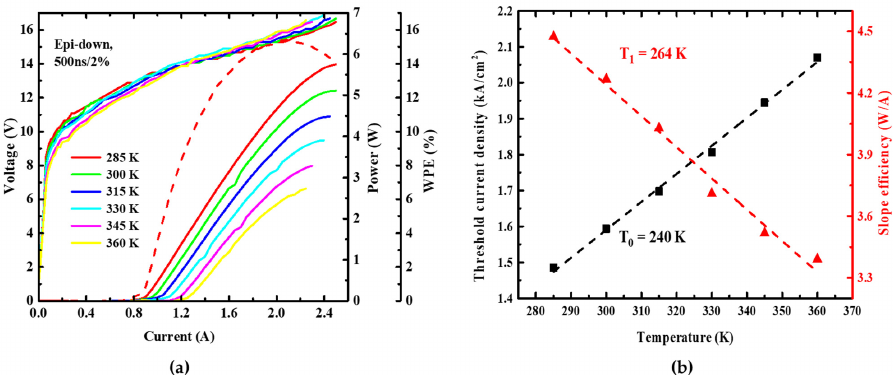
Figure 5. ( a ) Temperature-dependent P-I-V characteristics of QCL in pulsed mode. The red dash line shows the calculated WPE at 285 K. ( b ) Threshold current density and slope efficiency at different temperatures in pulse conditions at 500 ns, 2% duty cycle. The dashed lines represent exponential fits to the data. Figure 6a shows the beam image at 1.9 A in CW operation. The transverse mode was obtained by placing a pyroelectric camera 1.5 m away from the collimated chip. The beam shape remains basically unchanged with some beam steering at the maximum current density. This beam steering results from the onset of the first-order lateral mode at a high injection current. Figure 6b shows the far field pattern at different currents. The far-field pattern was obtained by fixing the device on a motorized rotation stage with 0.1° resolution about 40 cm away from the mercury cadmium telluride detector. Furthermore, beam steering was suppressed thanks to the temperature-insensitive design [28]. In addition, we have measured the beam M 2 at 1.5 A in CW mode as shown in Appendix B, Table A1. The calculated beam M 2 in the x -axis and y -axis direction are 1.146 and 1.045.